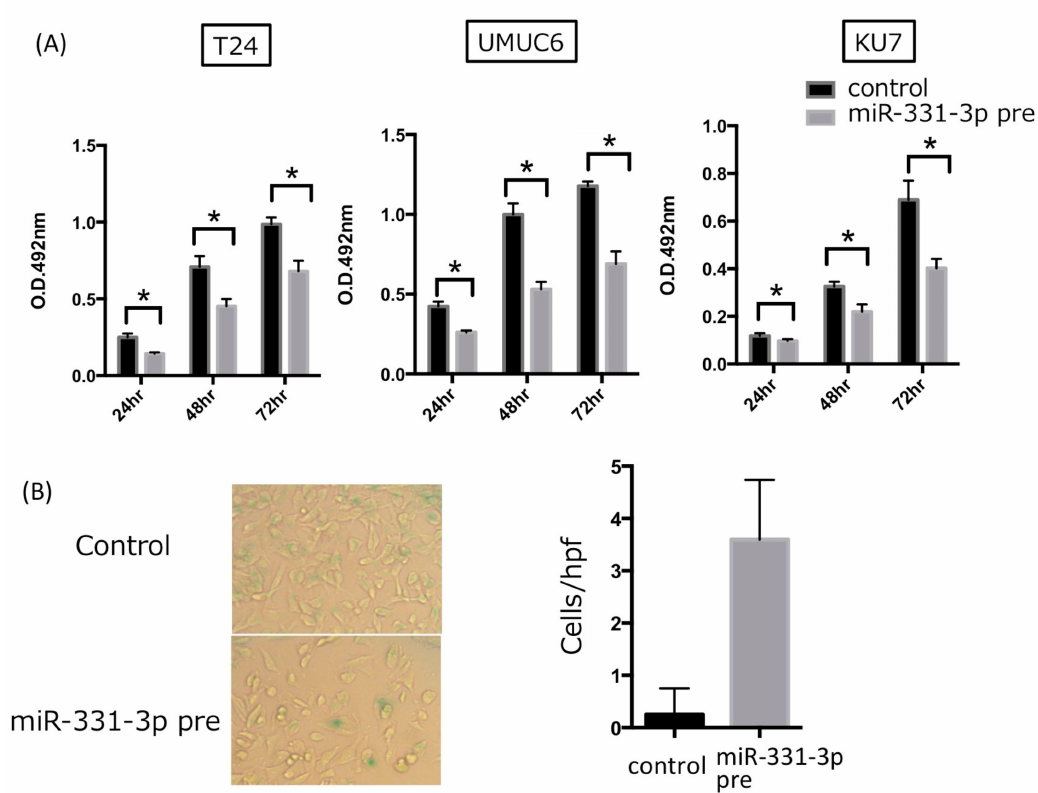
Figure 5. The effect of miR-331-3p on cell proliferation in three UC cell lines. ( A ) MTS assay. Cell proliferation was suppressed by overexpression of miR-331-3p. (* p < 0.05); ( B ) SA- β -gal assay for T24 cells. The Y-axis shows the number of positive cell counts per one high-power field (hpf). Positive cells were induced by transfection of miR-331-3p precursor (pre: precursor). Scale bar: ×